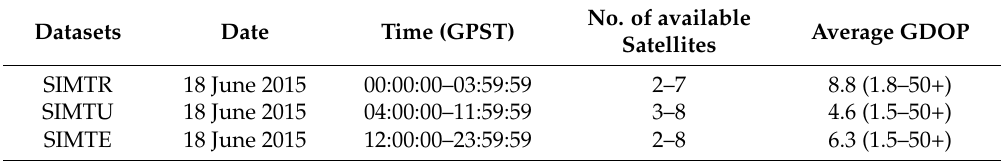
Table 4. List of data collected with a GNSS simulator; GDOP denotes Geometric Dilution of Precision.